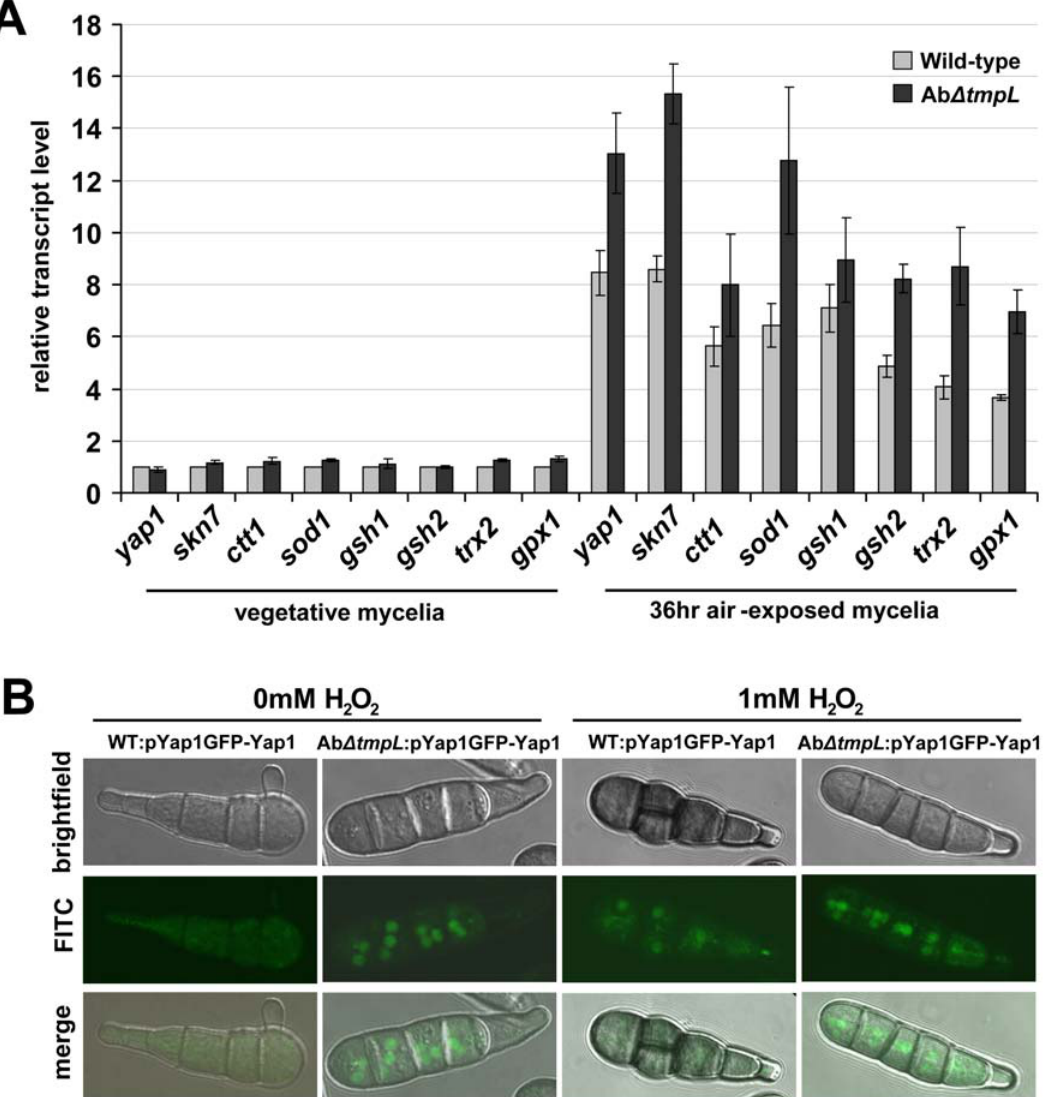
Figure 8. Expression of antioxidant-related genes and nuclear localization of GFP-Yap1 in A.brassicicola D tmpL mutants. ( A ) Transcript levels of antioxidant-related genes in vegetative mycelia and 36 hr air-exposed mycelia of A. brassicicola wild-type and D tmpL mutant. Relative transcript abundance was determined by comparing each gene transcript level with the transcript level of the same gene in vegetative mycelia of wild-type (set to transcript level=1). Data are mean 6 SD of three independent experiments. ( B ) Constitutive nuclear localization of GFP-Yap1 in A. brassicicola D tmpL mutant conidia. Distribution of GFP-Yap1 in the wild-type (WT:pYap1GFP-Yap1) and the Ab D tmpL mutant (Ab D tmpL :pYap1GFP-Yap1) during normal conidiation on CM (0 mM H 2 O 2 ) and following treatment of wild-type and Ab D tmpL mutant with H 2 O 2 for 1 hr (1 mM H 2 O 2 ).